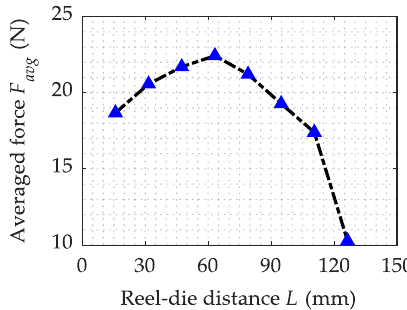
Figure 4. FEM calculation results of average ultrasonic drawing forces at different distances between the die and the reel